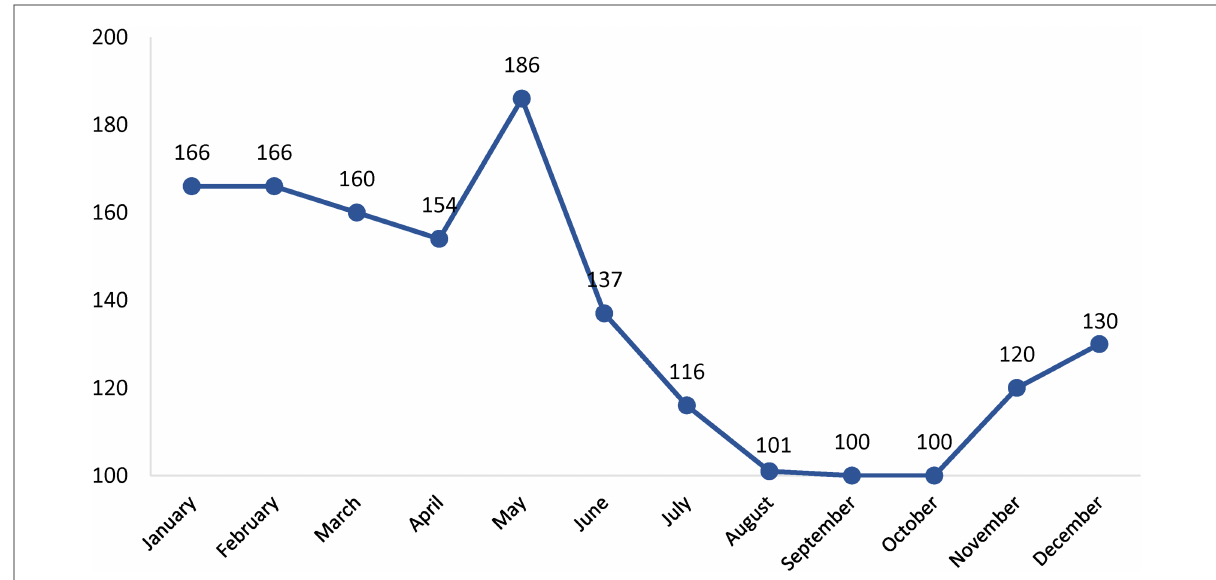
FIGURE 3 Monthly distribution of the Kawasaki disease in the country between 2007 and 2019.